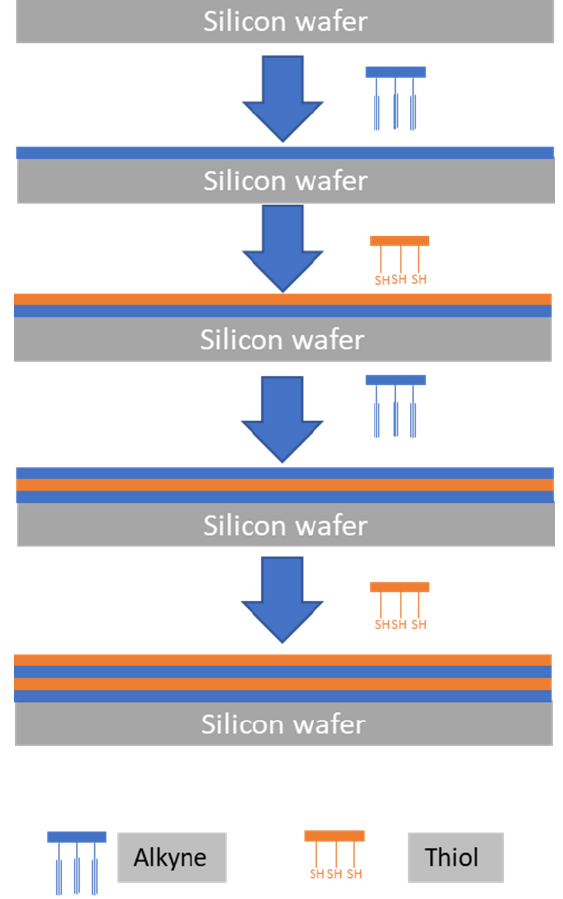
Figure 8. The use of soft/soft building blocks to tailor ultrathin multilayers though click chemistry. The silicon wafer is alternatively coated with azide-functionalized dendrimers and alkyne-functionalized dendrimers. The illustration is based on the work conducted by [42].